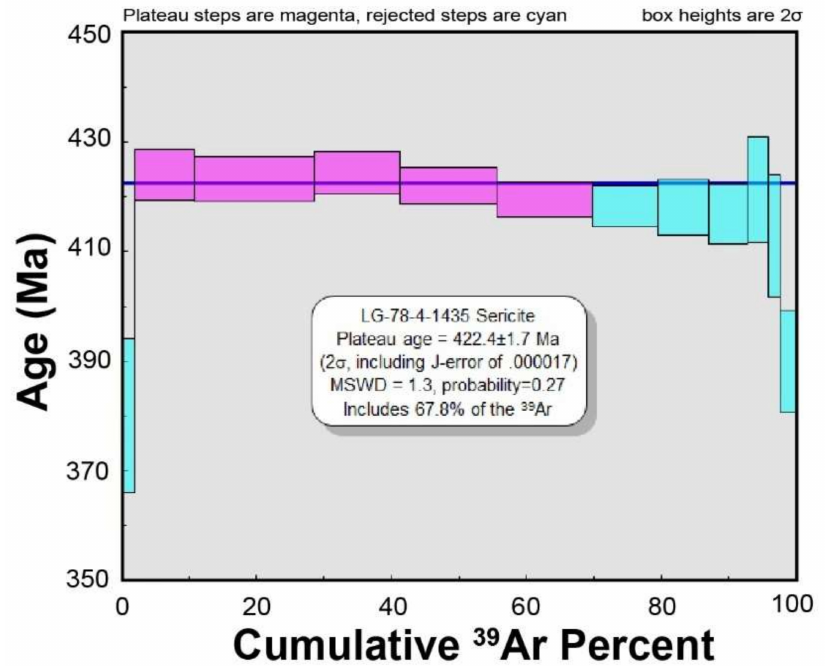
Figure 21. 40 Ar / 39 Ar age spectrum of muscovite from the sericitic alteration surrounding gold-bearing quartz–carbonate veins from drill core sample